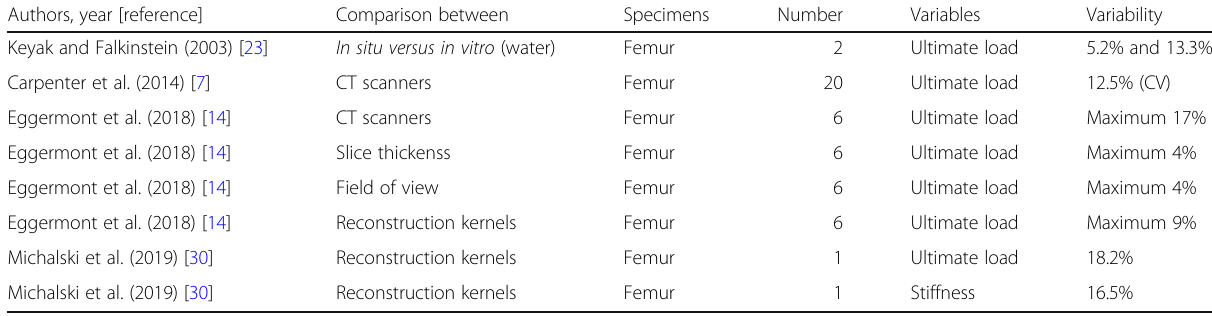
Table 1 Reported variability of finite element results as an effect of different computed tomography parameters Authors, year [reference] Comparison between